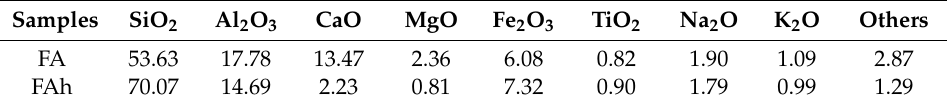
Table 1. Chemical composition of FA and FAh (wt